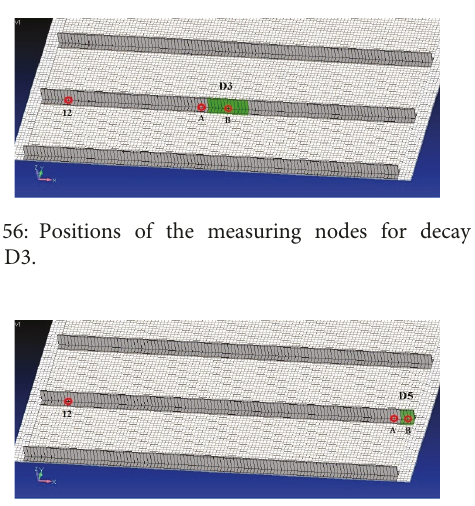
Figure 57: Positions of the measuring nodes for decay tests, damage D5.